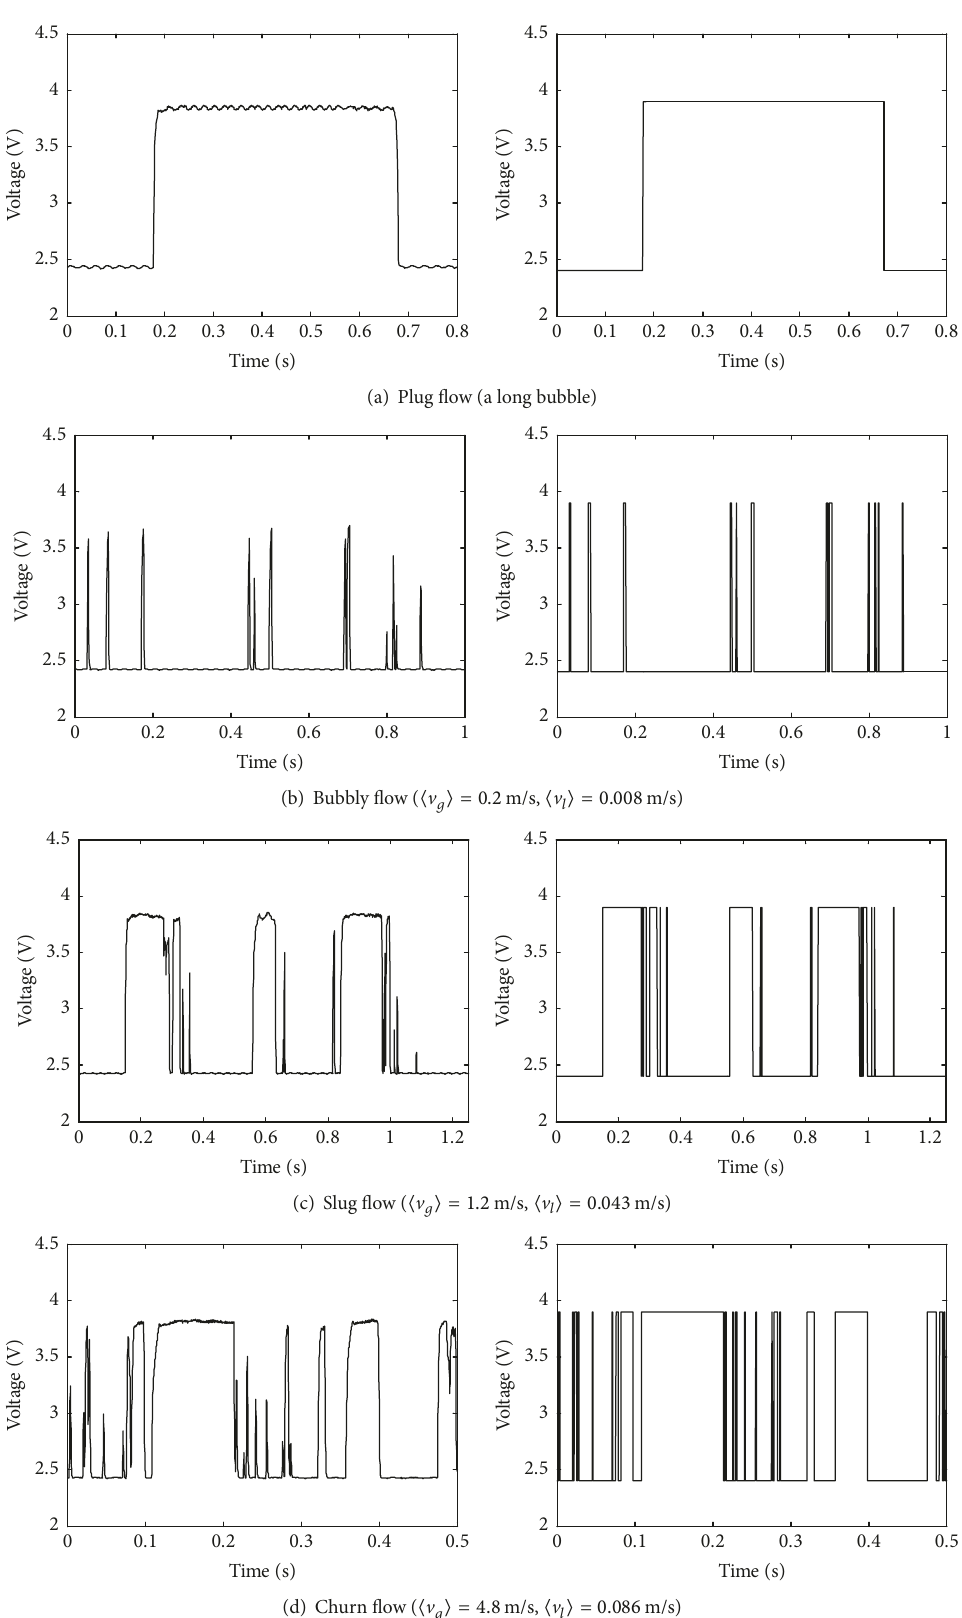
Figure 19: Data processing results for typical two-phase